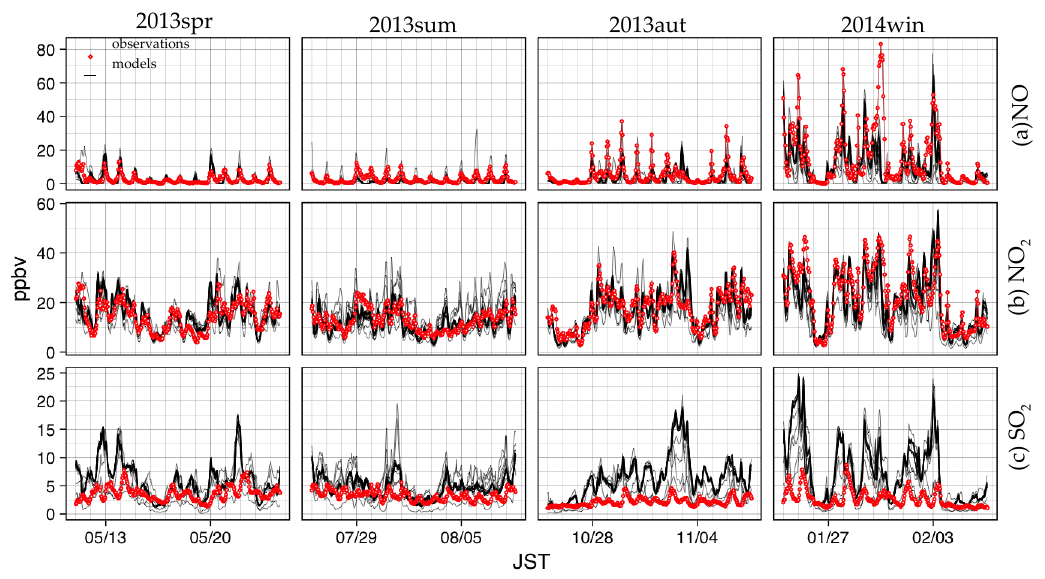
Figure 6. Spatial averages of observed and simulated hourly concentrations for ( a ) NO, ( b ) nitrogen dioxide (NO ), and ( c ) sulfur oxide (SO ) from different AAPMSs within d03 over the four seasons.